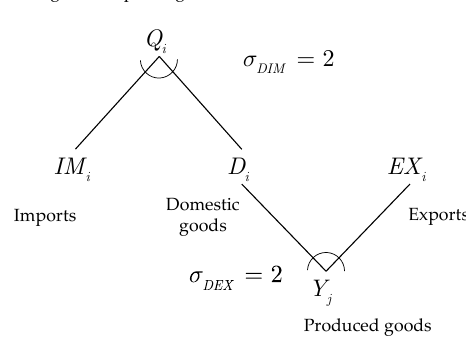
Figure 3. Structure of exports and imports.